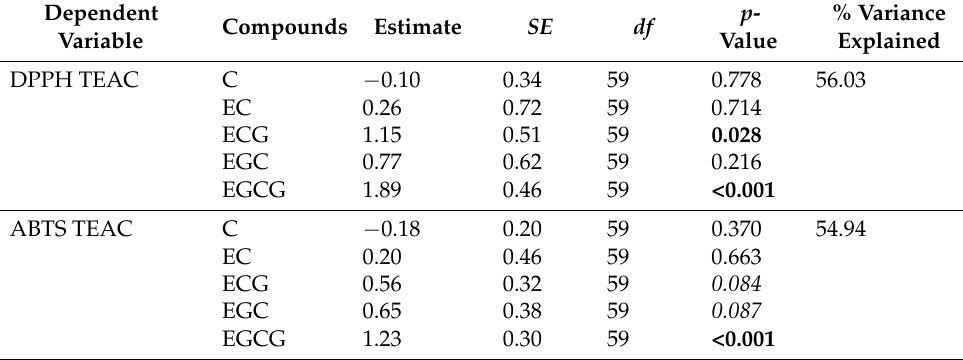
Boldface values represent p < 0.05, italic values represent p <